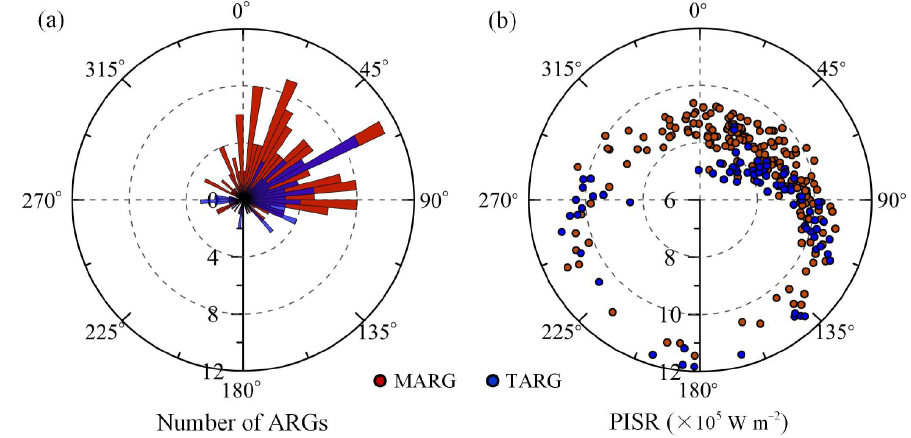
Figure 6. (a) Histogram of the aspect angles for the MARGs (red) and TARGs (blue), respectively. (b) Wind rose plot shows the variations of potential income of solar radiation (PISR) with aspect angles.